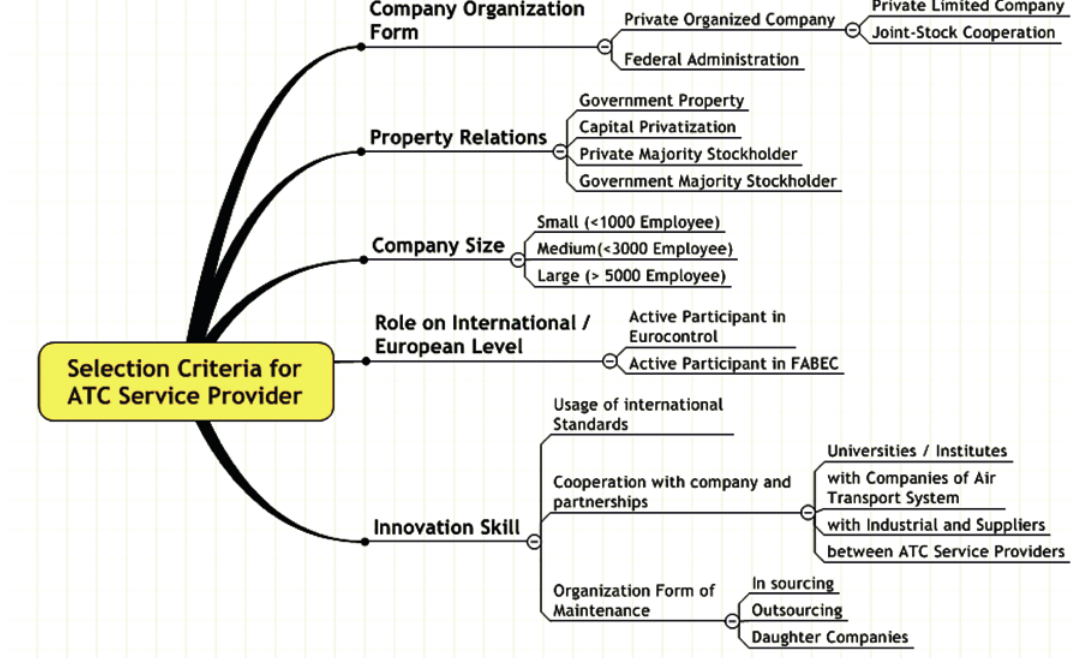
Fig. 2. Set of selection criteria for ATC service Table 1 . Overview of ATC service provider analysis Criteria